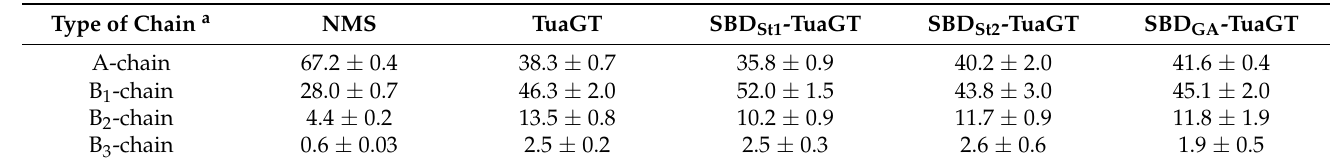
Table 4. Percentage of different chains in normal maize starch (NMS) before and after modification by Tu α GT and SBD-Tu α GT